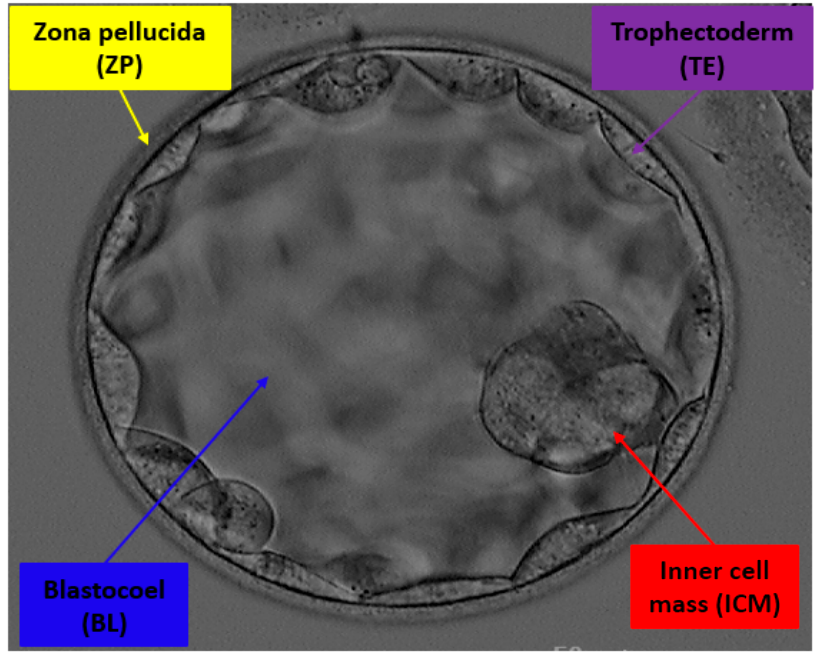
Figure 1. Example of blastocyst microscopic image with components ZP, TE, BL, and ICM, whose specific morphologies are considered to determine the viability of an embryo for IVF.